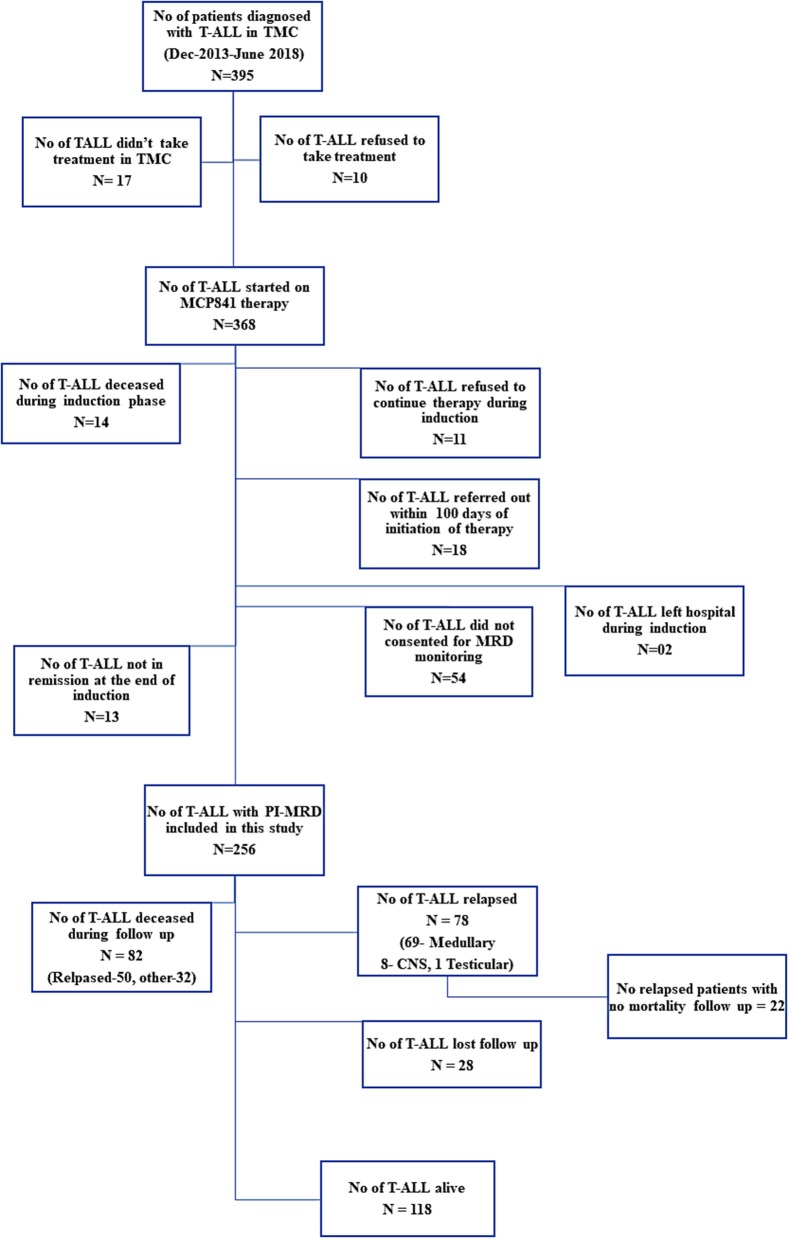
Distribution of patients and the follow-up information available for MRD analysis in the study.